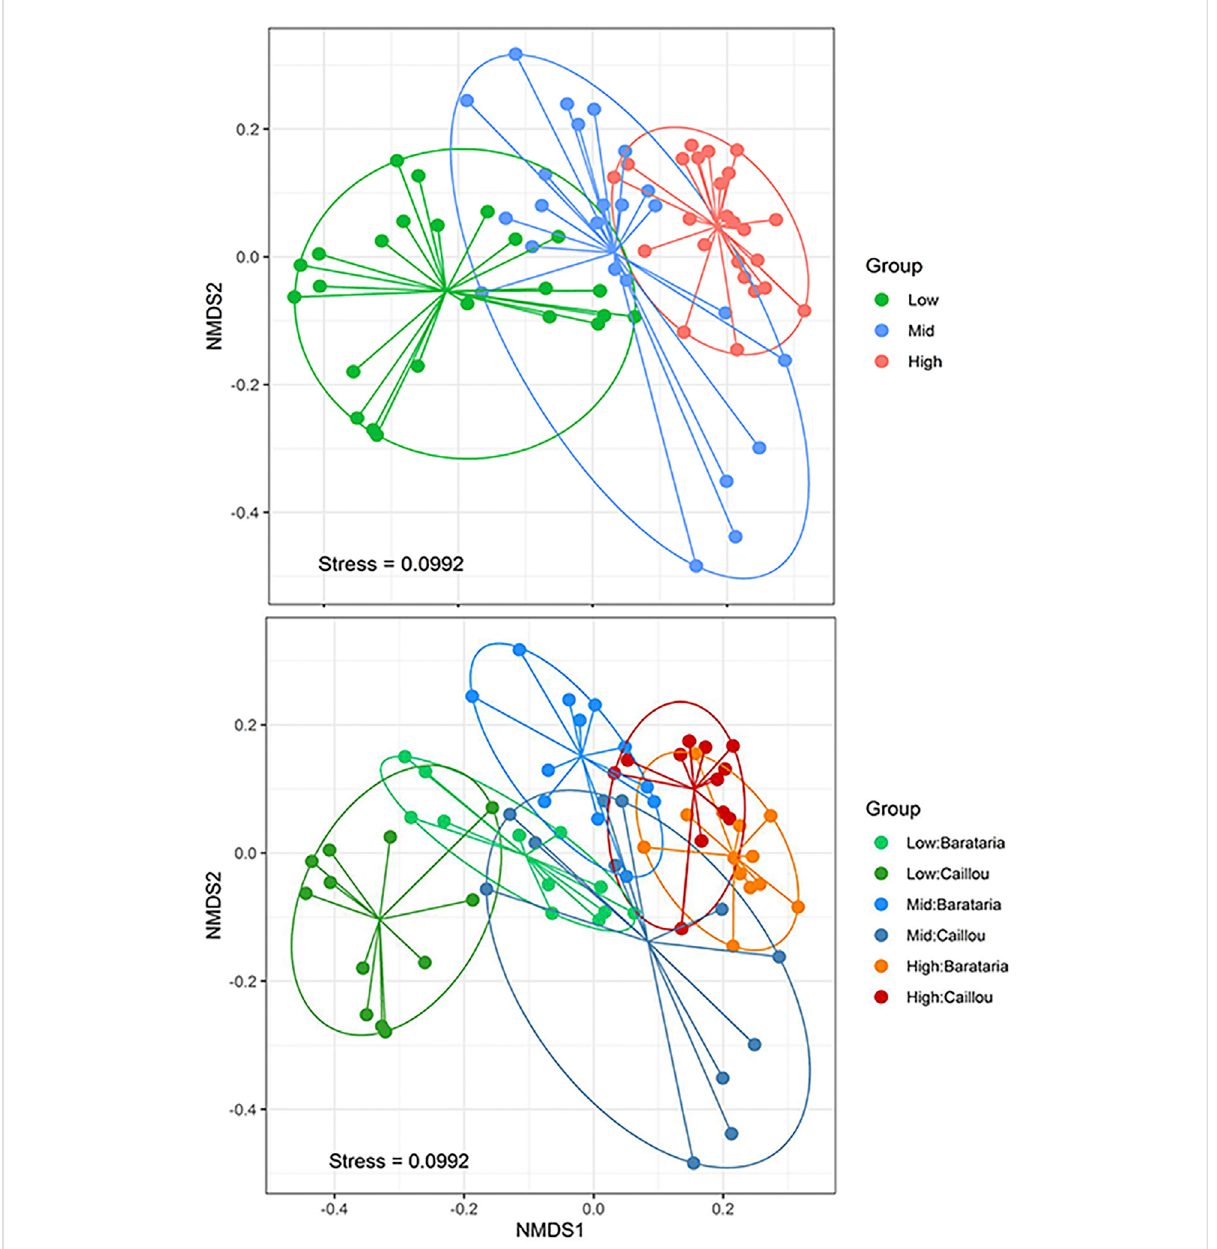
FIGURE 4 Plot of the fi rst two dimensions of the NMDS ordination of the Sørensen distance matrix, with salinity zones (top) and from each bay (bottom). Dotsrepresentthemetazoancompositionofindividualsamples.Solidellipsesrepresenttheellipticalhullsofthegroups.Solid,straightlinesconnect a sample to the group centroid. Stress denotes the goodness of fi t of the regression of the original distance matrix values against the ordination